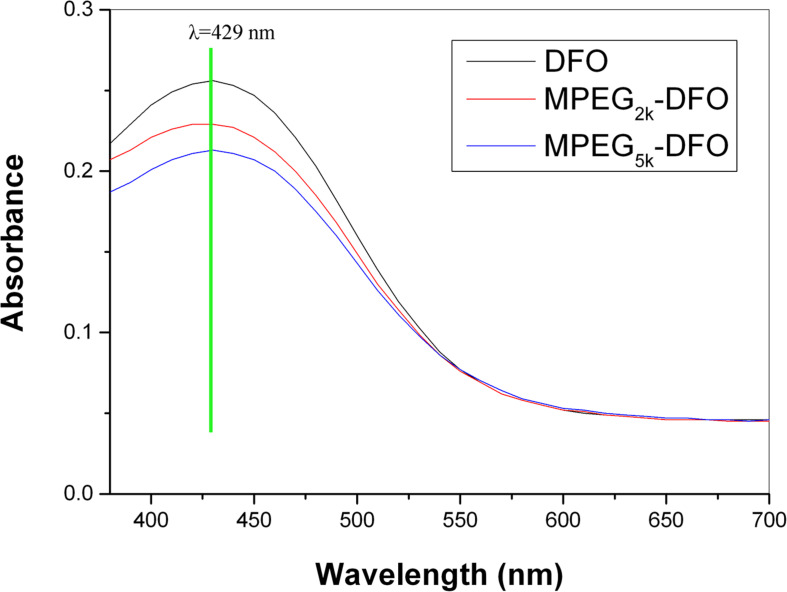
Full-length UV-Vis scanning of PEGylated DFO.